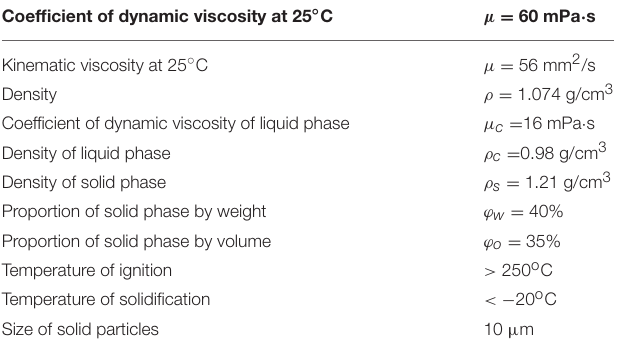
TABLE 2 | Basic information on ERF#6